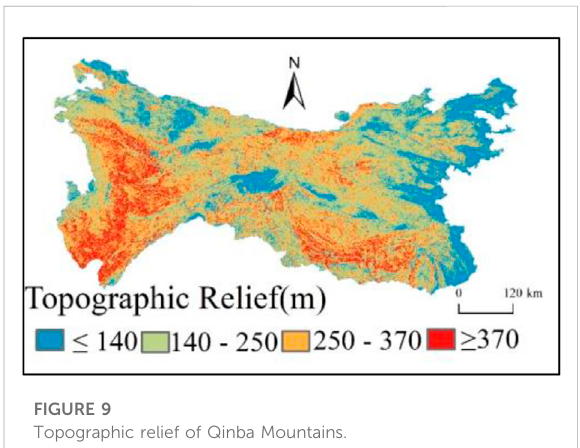
FIGURE 9 Topographic relief of Qinba